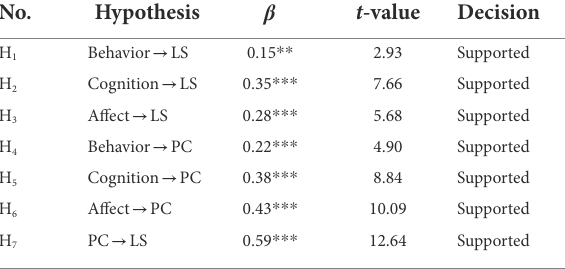
TABLE 6 Main regression results in the proposed research model.